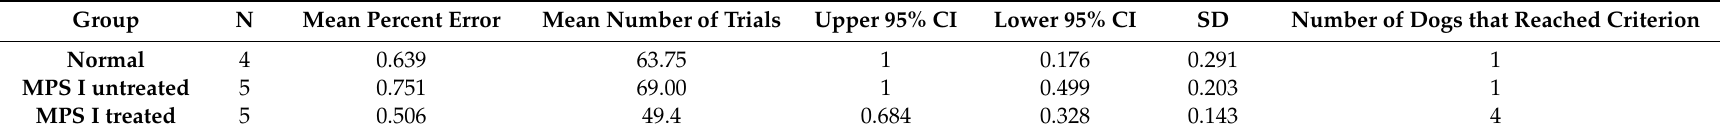
Table 4. DNMP descriptive statistics by group for 20-s delay. This includes the number of dogs tested (N) from each group, mean (real) percent error of each group, mean (real) number of trials performed by each group, 95% confidence interval, standard deviation, and number of dogs from each group that reached the criterion at the 20-s delay.